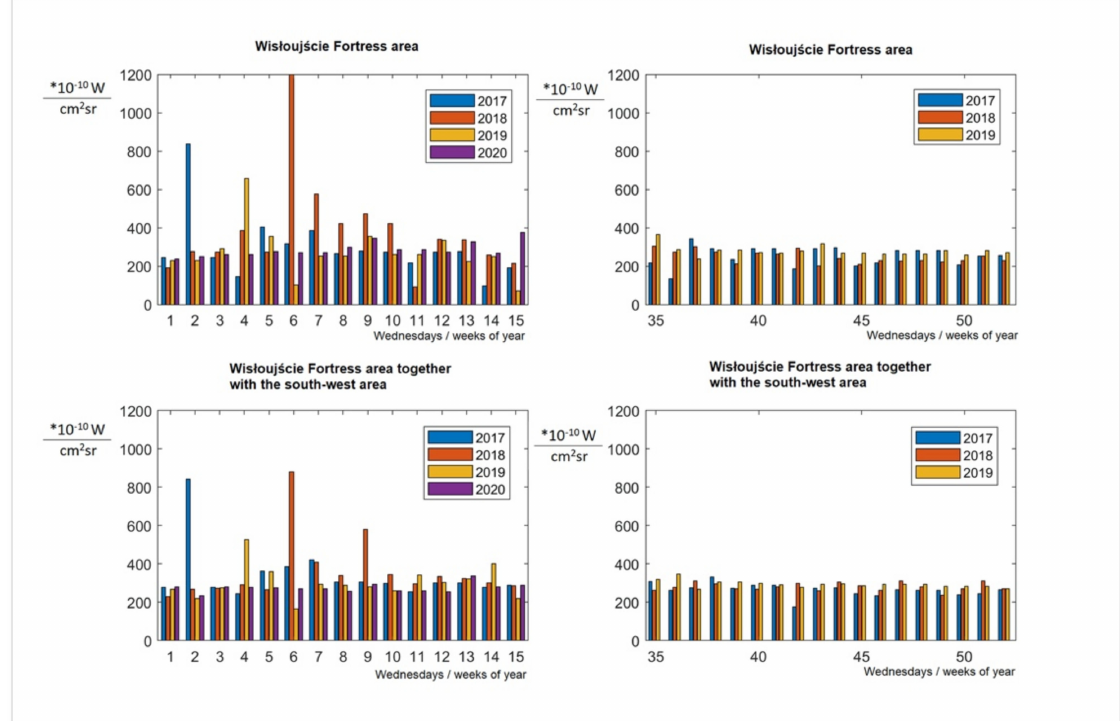
Figure 18. Graph of the radiance value for individual Wednesdays/weeks of the 2017–2020 period in the analysed areas. Source: authors’ elaboration. * Unit of